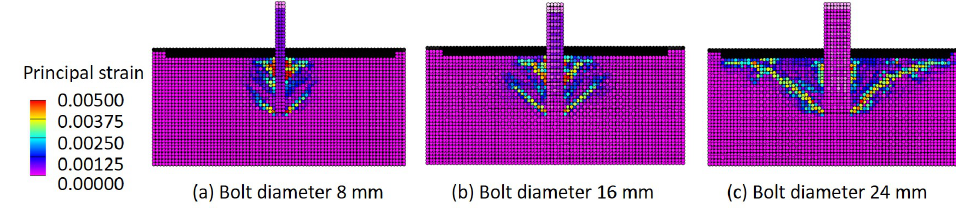
Figure 14. Effect of anchor bolt diameter on the fracture